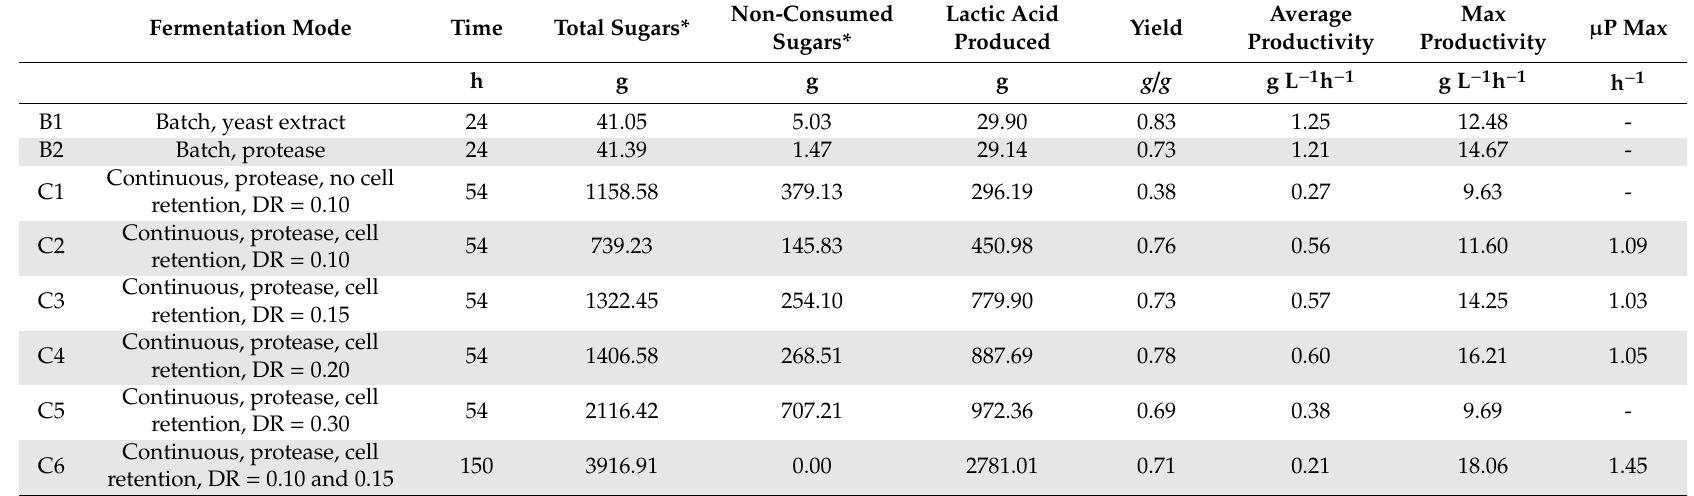
Table 1. Main results obtained from the di ff erent fermentation processes with Bacillus coagulans A166. The values were obtained through the mass balance calculations. Fermentation Mode Time Total Sugars*